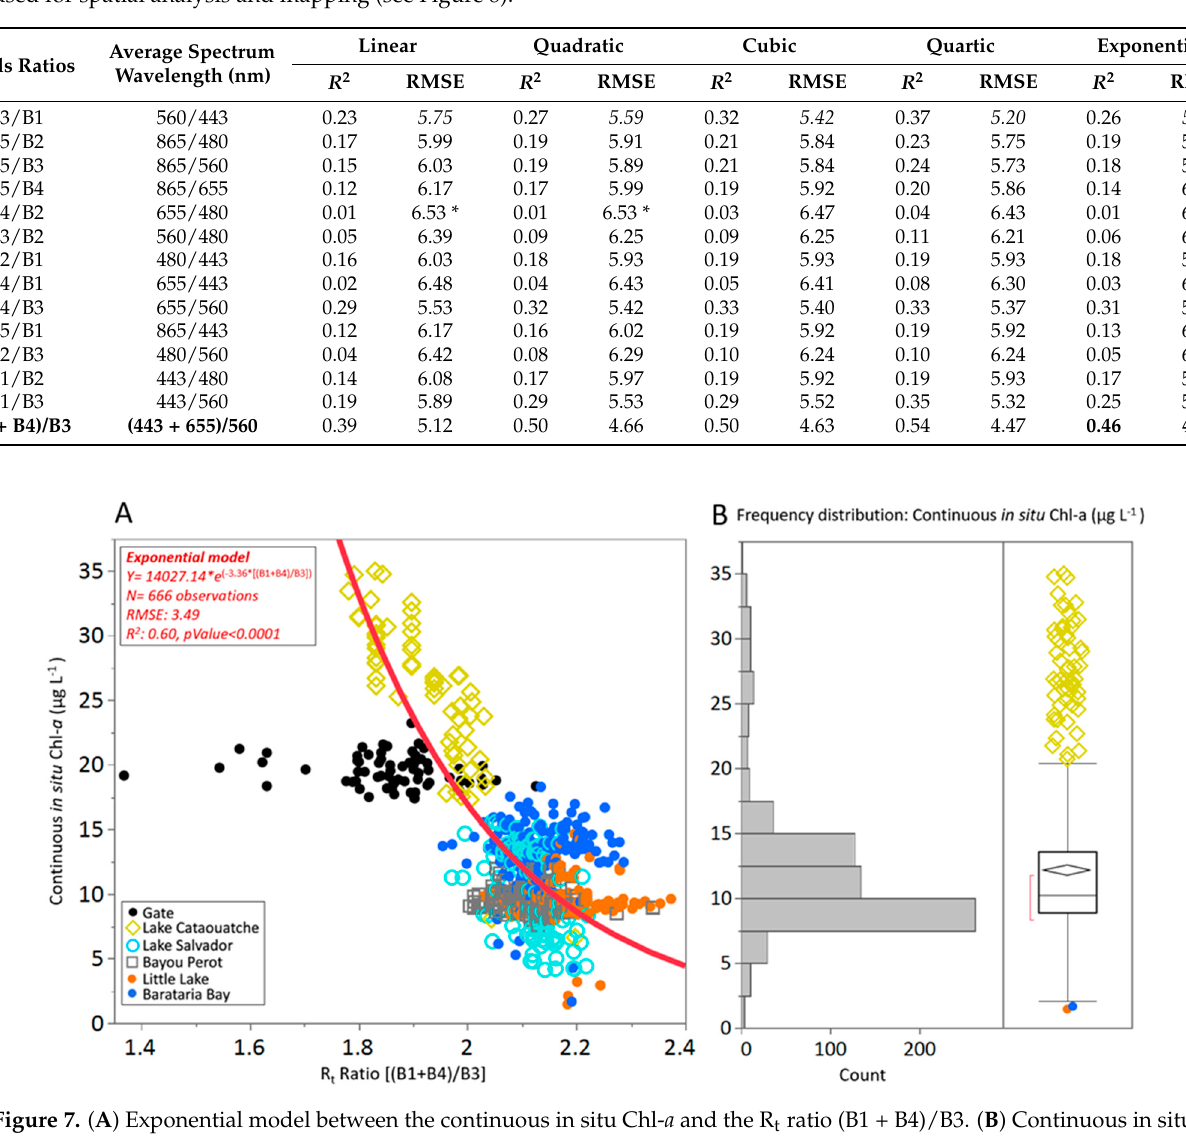
Figure 8. Linear regression between the model predicted continuous in situ Chl- a and the valida- tion data subset (see Methods section). The solid black line shows the 1:1 relationship. The solid bold red line is the regression line; dashed red lines represent the 95% confidence interval.